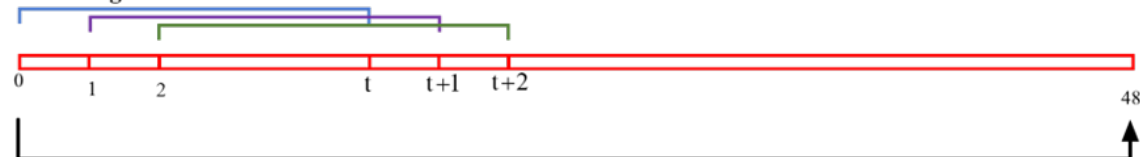
Figure 4. Illustration of the RH control strategy.